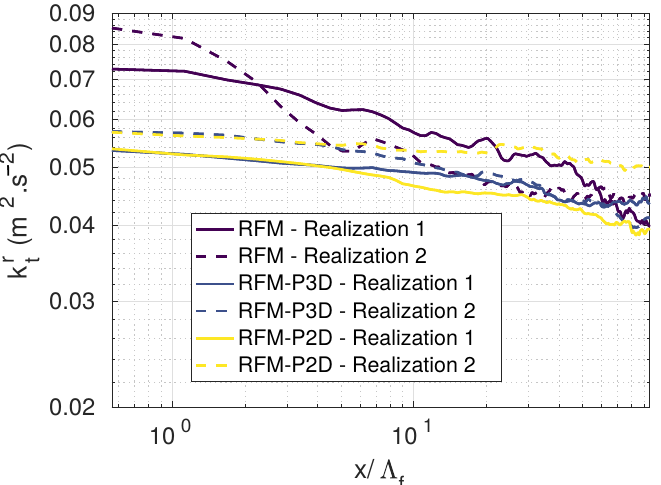
Figure 9. Resolved turbulent kinetic energy k r configuration